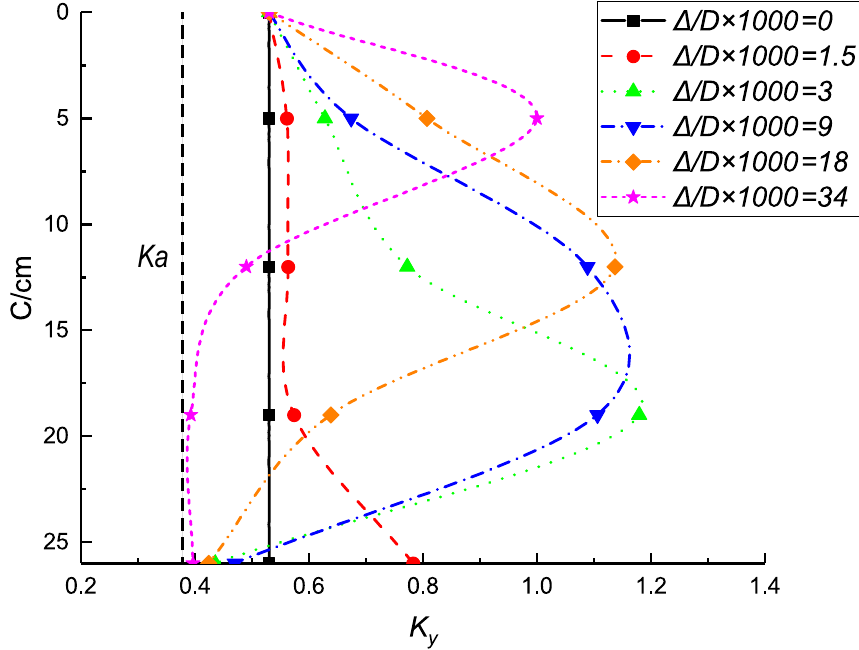
Figure 17. Variation in the longitudinal lateral pressure coefficient (without the pipe